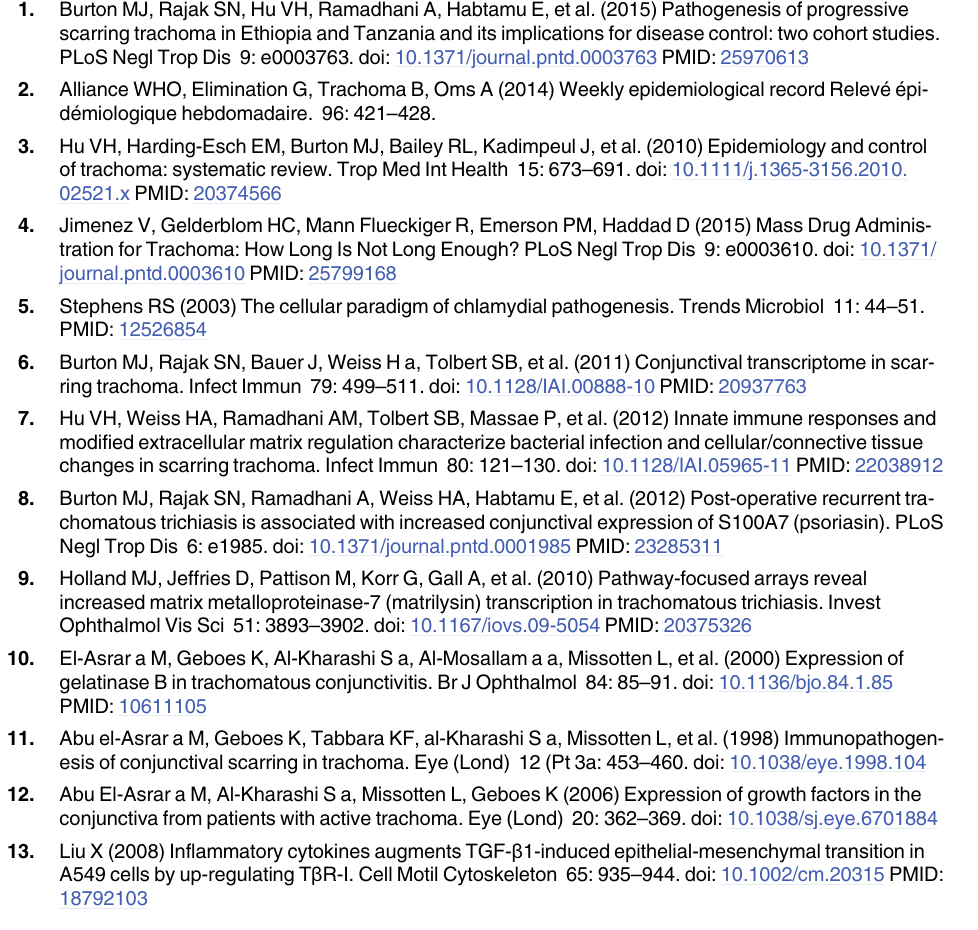
S1 Fig. Cross-polarized light images of haemotoxylin and eosin stained tissue sections. Example images representative of “ block ” (A), “ wavy ” (B) and “ fine ” (C) patterns of fibrosis are shown. Images were taken at 200X original